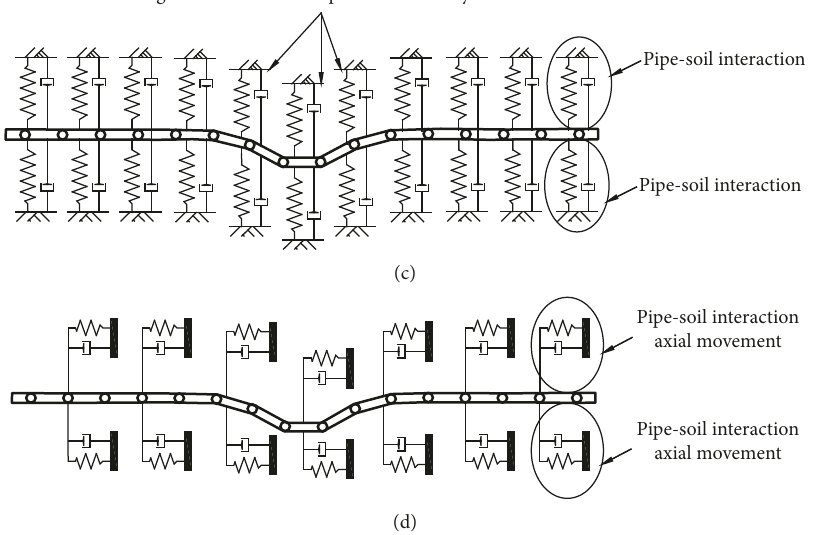
Figure 3: Schematic diagrams of pipe-soil interaction. (a) Vertical pipe-soil interaction (when the maximum ground settlement is located beneath a joint). (b) Axial pipe-soil interaction (when the maximum ground settlement is located beneath a joint). (c) Vertical pipe-soil interaction (when the maximum ground settlement is located beneath the centre of pipe segment). (d) Axial pipe-soil interaction (when the maximum ground settlement is located beneath the centre of pipe